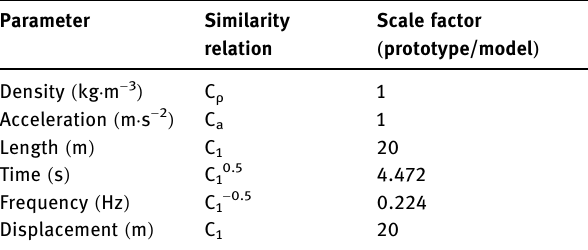
Table 5: Primary similitude coe ffi cients of the model Parameter